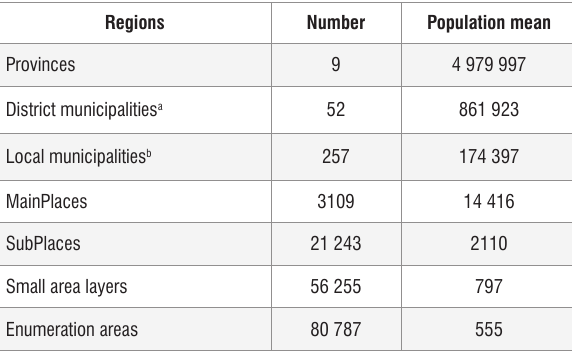
South African geographical levels or regions for census